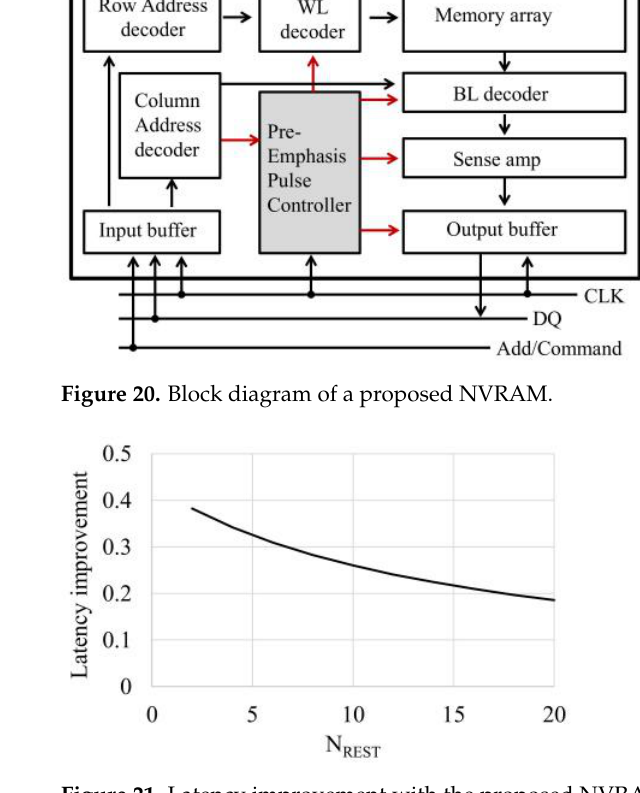
Figure 21. Latency improvement with the proposed NVRAM